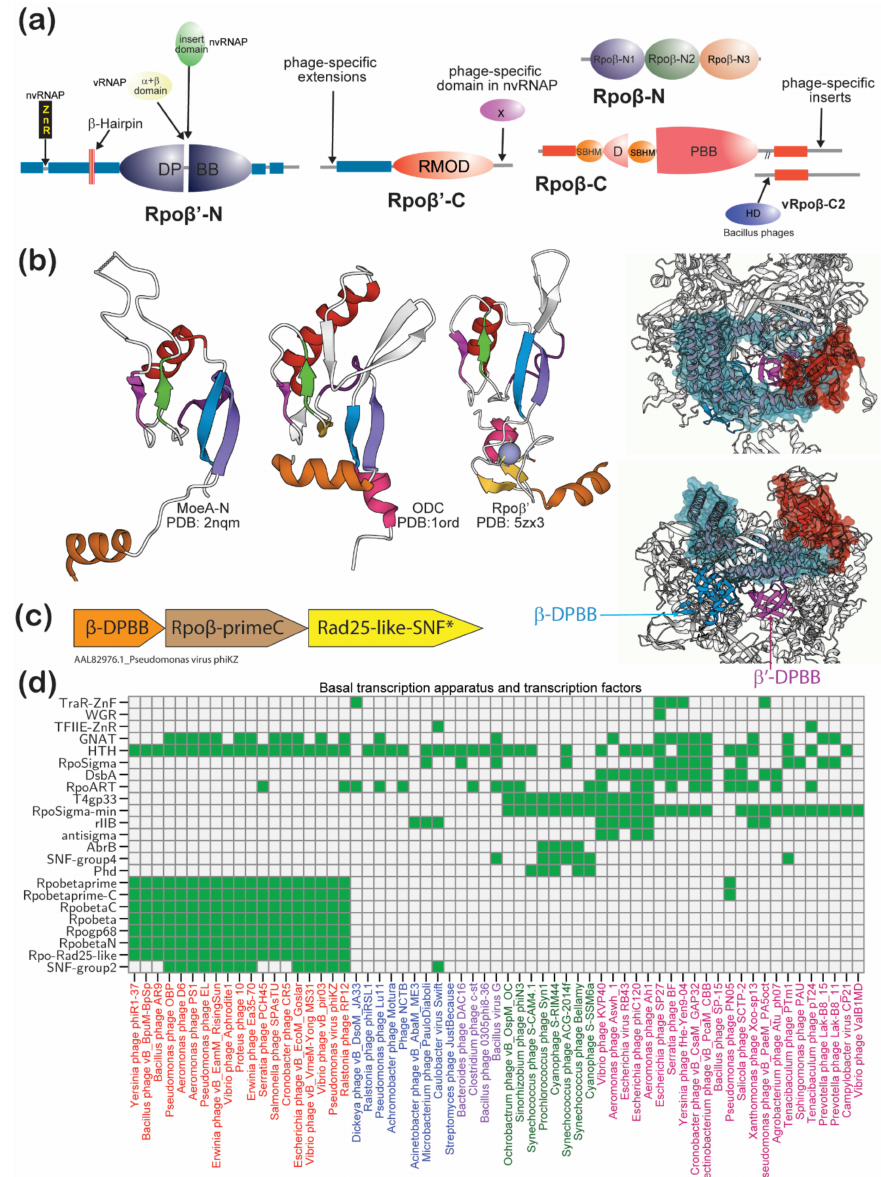
Figure 4. Basal transcriptional proteins and transcriptional factors in jumbo phages. ( a ) Domain architectures of the RNA polymerase β and β ’ subunits found in group 1 phages. Distinct domains are colored differently. The arrows show the distinct regions of the virion (vRNAP) and nonvirion (nvRNAP) RNA polymerase-specific insertions in the universally conserved cores. ( b ) Cartoon structures of the conserved core of the RMOD domain and its location in the transcript-exit channel of the β ’ subunit. On the left are MOL* cartoon renderings of the MoeA-N, the ornithine decarboxylase and the C-terminal domain of the β ’ subunit and on the right are two views of the RNA polymerase, with the β ’ subunit shaded blue and the RMOD domain brick red. ( c ) Gene neighborhood of the Rad25-like ATPase found in group 1 phages. The accession number in the label corresponds to the gene marked with a *. ( d ) Phyletic vector diagram of various proteins involved in transcription and transcriptional regulation. Filled green squares indicate presence of a gene. Phage names are colored by their corresponding groups. This phage order has been maintained for all vector diagrams in the